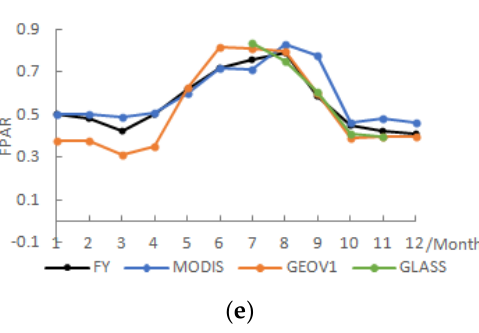
Figure 7. FPAR time series change chart of the study area (2014); ( a ), ( b ), ( c ), ( d ), and ( e ) are the grassland, cropland, shrub, broadleaf forest, and needleleaf forest study areas, respectively.